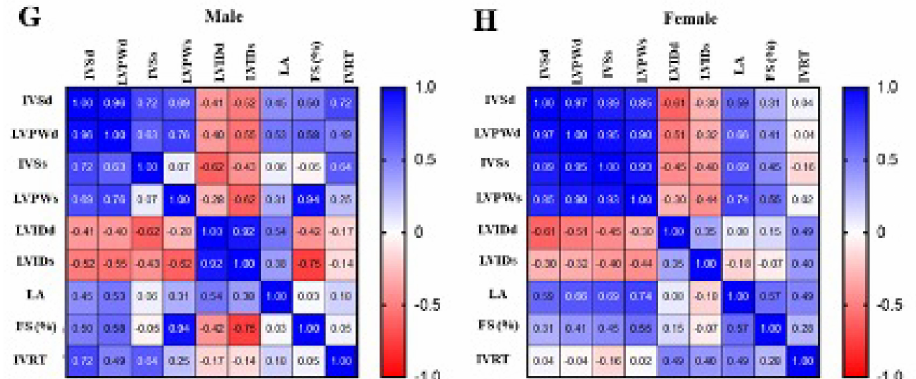
Figure 2. The correlation matrix of baseline characteristics and echocardiography among groups of Bengal cats with MYBPC3-A74T gene mutation. HET = heterozygous mutation; HOM = homozygous mutation; LA = left atrium; AO = aorta; IVSd = interventricular septal at end-diastole; LVPWd = left ventricular free proximal wall diameter at end-diastole; LVIDd = left ventricular internal diameter at end-diastole; IVSs = interventricular septal at end-systole; LVPWs = left ventricular free proximal wall diameter at end-systole; LVIDs = left ventricular internal diameter at end-systole; FS = fractional shortening; PV Vmax = pulmonary valve maximum blood velocity; AV Vmax = aortic valve maximum blood velocity; FS = fractional shortening; IVRT = isovolumic relaxation